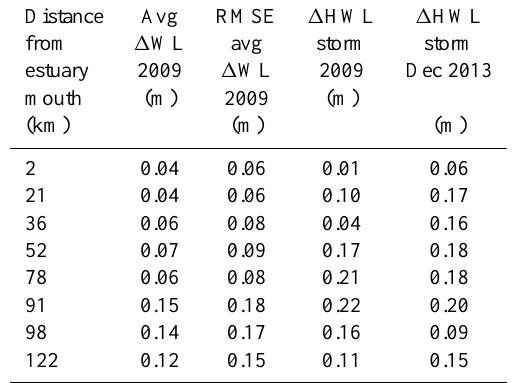
Table 1. Average and RMSE (for the whole year 2009) of difference in measured and modeled water level ( (cid:49) WL) for tide gauge stations with different distance from the estuary mouth. Difference between measured and modelled high water level ( (cid:49) HWL) for the storm of 9 February 2009, and the storm of 6 December